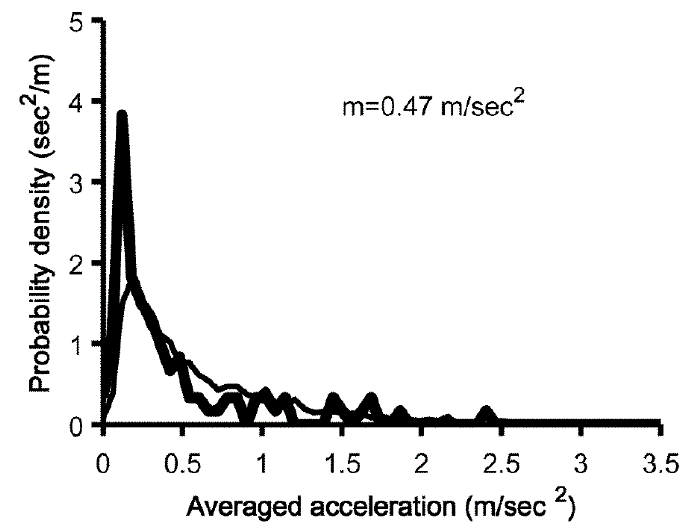
Figure 1. Probability distribution of the averaged acceleration per 10 min, obtained from continuous 24 h recording. Thin lines: distribution curve of 15 healthy volunteers, thick line: distribution curve of a representative 72-year-old man with Parkinson’s disease.